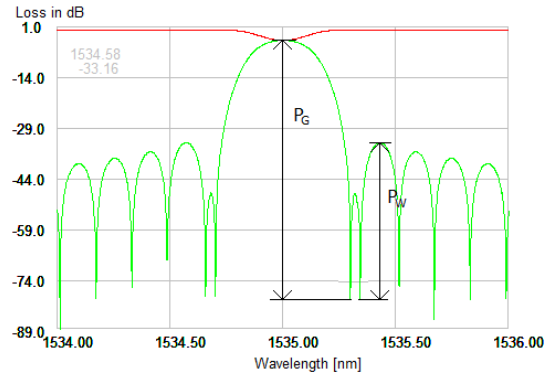
and , when the first-line 𝑃𝑃 𝐺𝐺 𝑃𝑃 𝑊𝑊